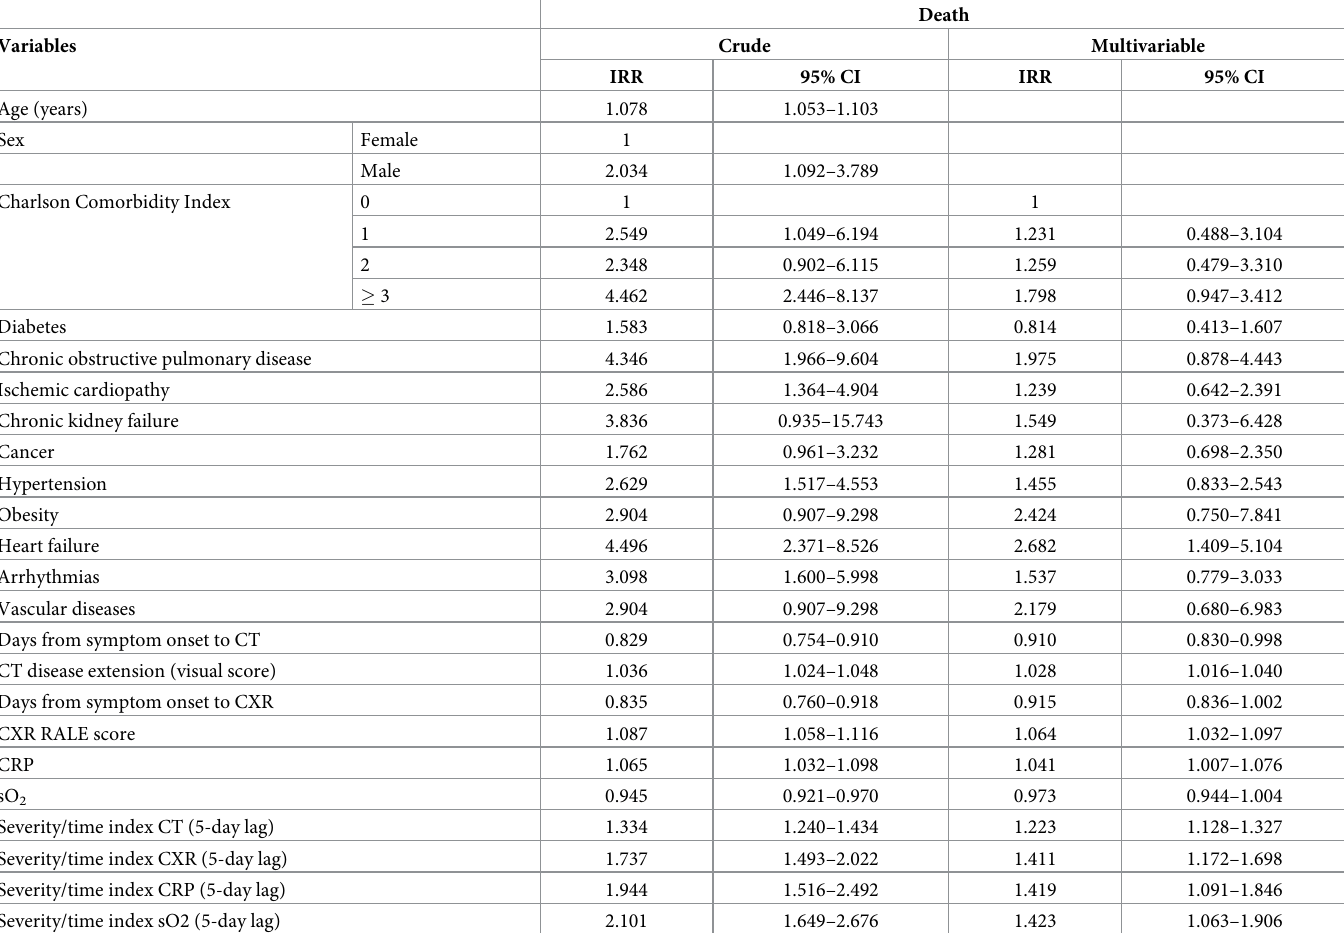
Table 2. Associations of pre-existing conditions and laboratory and radiological findings with death, crude and after adjustment for age and